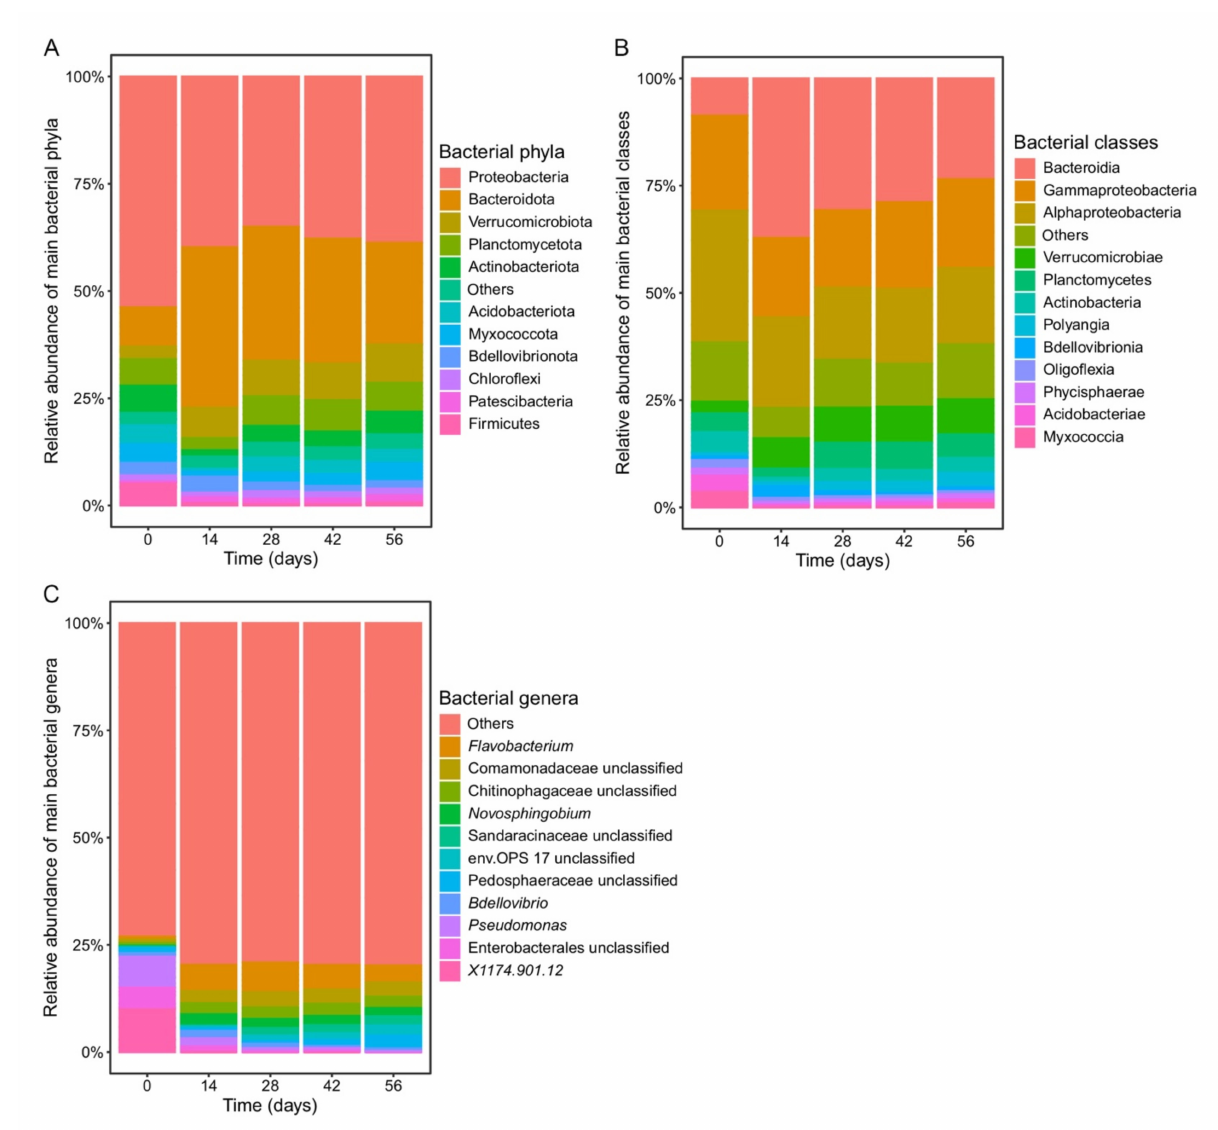
Figure 2. Changes in the bacterial community composition at the phylum ( A ), class ( B ), and genus ( C ) level during vermicomposting of silver wattle. Bars represent the relative abundance of dominant bacterial phyla. Low abundant bacterial taxonomies (relative abundance < 1%) were collapsed into